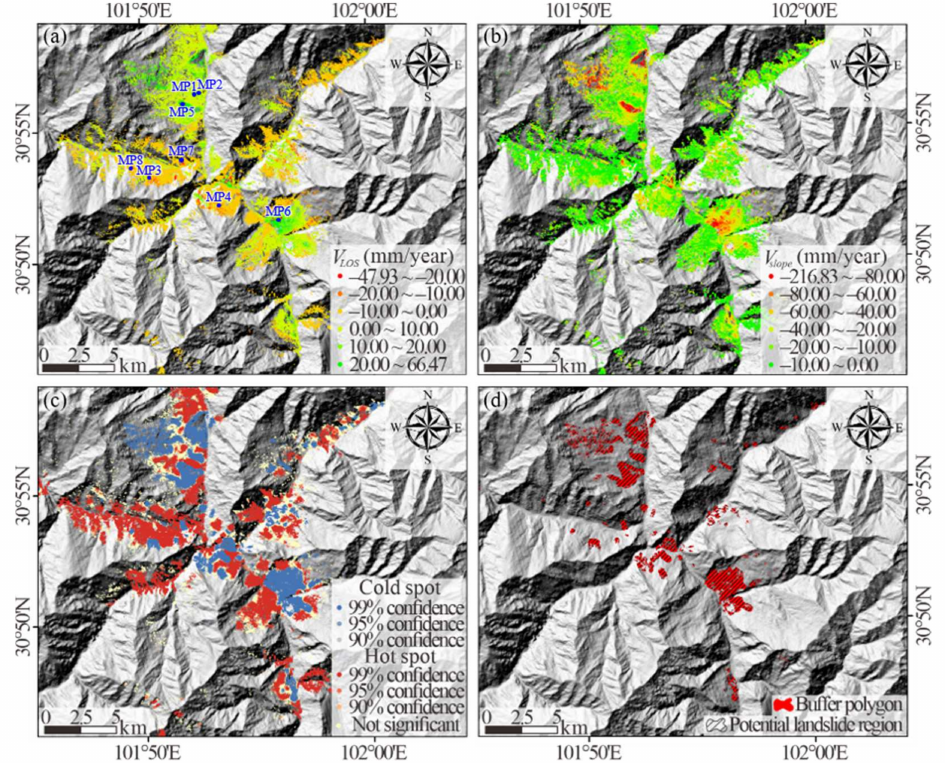
Figure 8. Some results produced during implementing the proposed interpretation approach: ( a ) MPs obtained in the good visibility areas of the ascending–descending Sentinel-1A datasets; ( b ) Conversion analysis results of the deformation rates of the MPs; ( c ) Hotspot analysis result of the obtained deformation rate along the steepest slope direction V slope of MPs.; and ( d ) Buffer analysis results of the MPs grouped into cold spots in the study